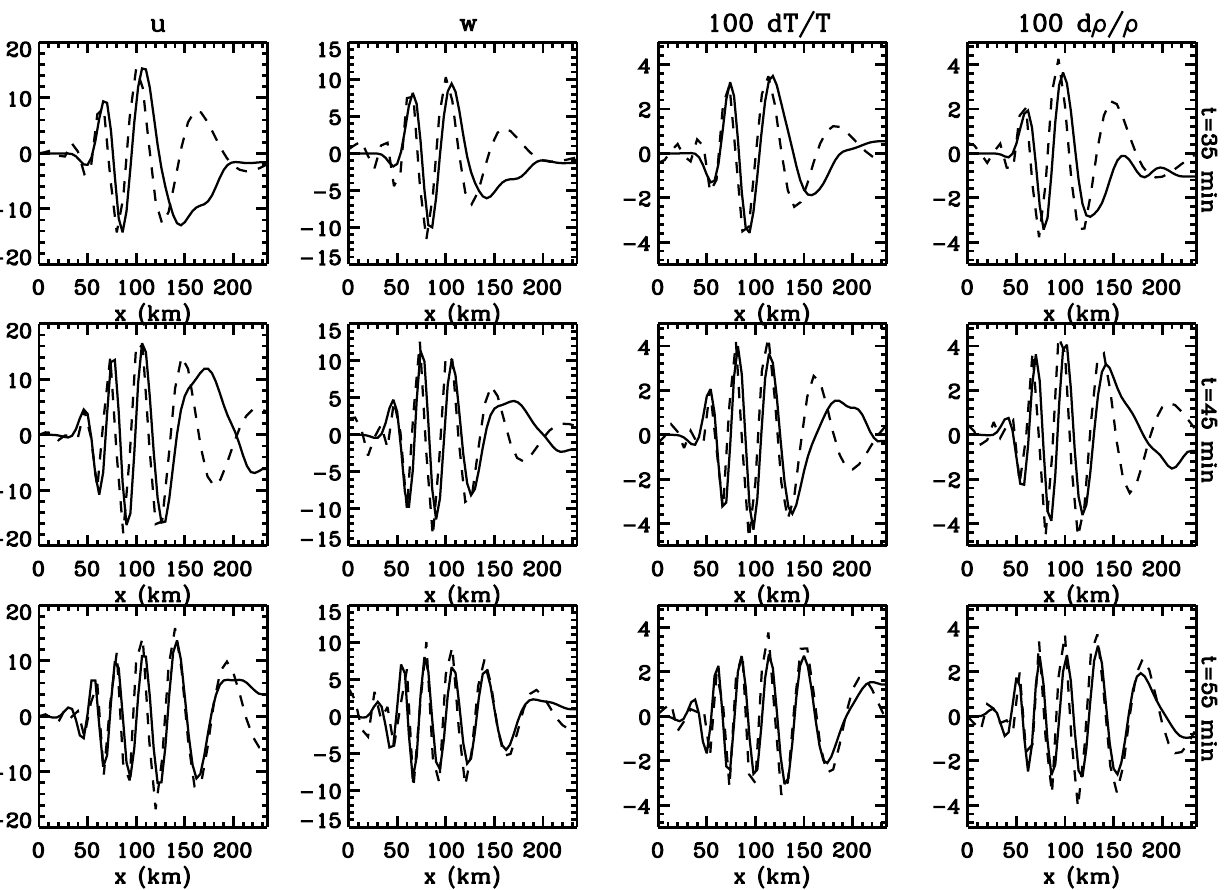
Fig. 13. Ray traced GW amplitudes as compared to FL amplitudes at z = 70km and y = 0 for the same convective plume. The first, second, third, and forth columns show the GW perturbation fields u , w , 100 T 0 /T , and 100 ρ 0 /ρ , respectively. Upper to lower rows show the results at t = 35, 45, and 55min, respectively. Solid lines show the ray trace results, while dash lines show the FL Boussinesq results.